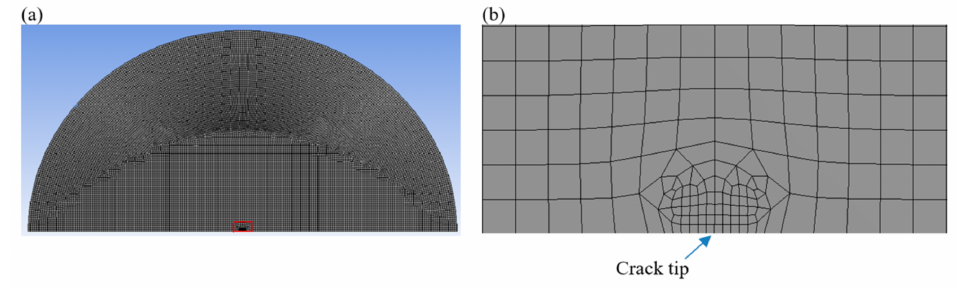
Figure 3. ( a ) Finite element model (coarse mesh) of the full model. ( b ) Semicircular finite element model with fine mesh at the crack tip.